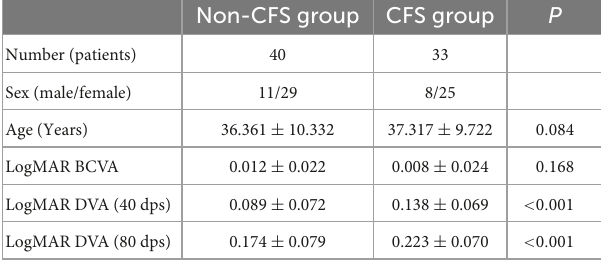
TABLE 4 Comparison of DVA between CFS and non-CFS